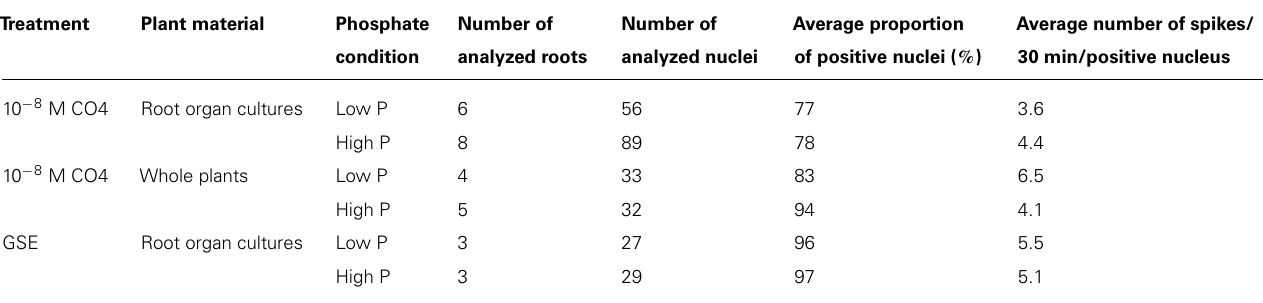
The table indicates the number of independent root samples analyzed and the number of nuclei in which fluorescence was monitored. Positive nuclei are those showing at least one spike over the 30-min recording period. Data obtained in low P and high P were compared for each combination of treatment and material. No statistically significant difference was found between low P and high P for the percentage of positive nuclei, according to Student’s t-test or Mann–Whitney’s test (P > 0.9 in all cases). The effect of phosphate concentration on the number of spikes/30 min imaging was tested by nested ANOVA to take into account possible variations between sampled roots (root factor nested in the phosphate concentration). Normality of residues was verified using the Kolmogorov–Smirnov’s test. No statistically significant difference between low P and high P was found using Fisher’s LSD test (P > 0.1 for all combinations of treatment and